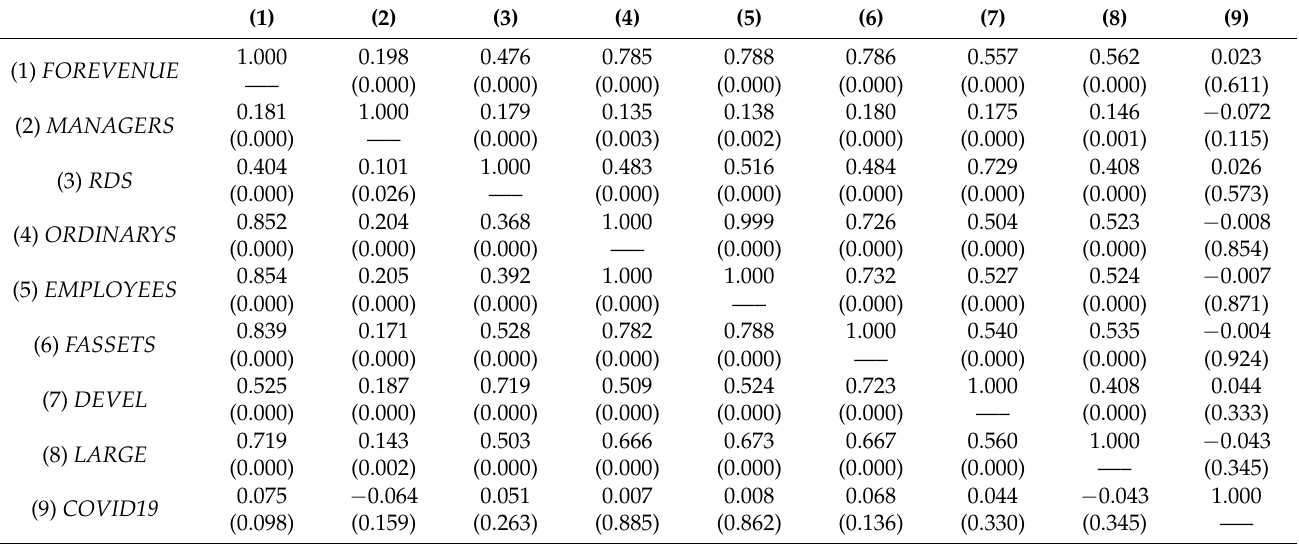
Table 3. Pearson and Spearman correlation coefficients between variables in this study ( p -values in parentheses).